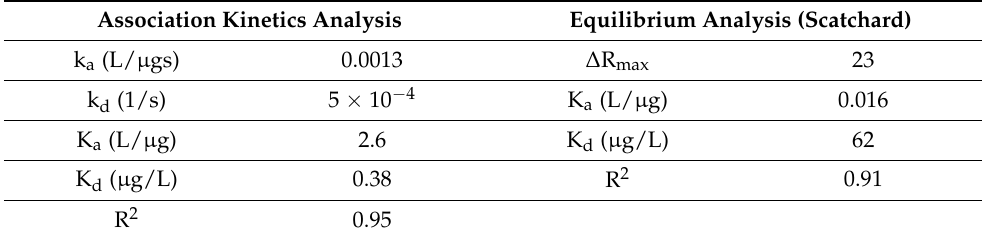
Table 1. Equilibrium and association kinetics constants. Association Kinetics Analysis Equilibrium Analysis